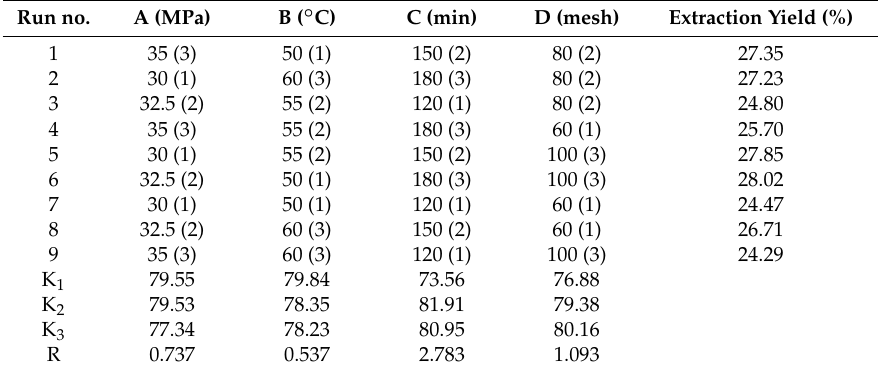
Table 1. Assignment of the factors and levels using an OA 9 (3 4 ) matrix along with results obtained for SFE of EDS oil.